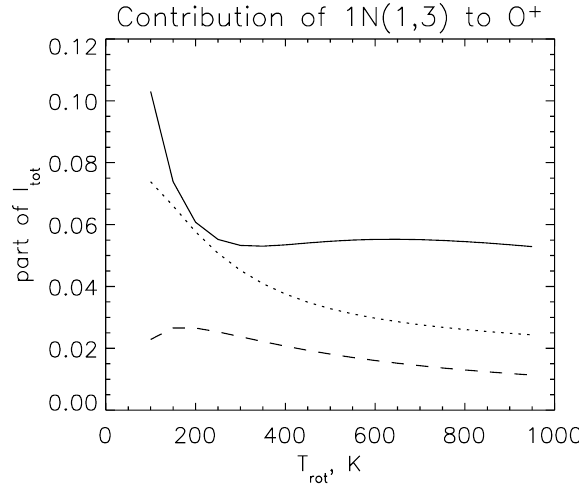
Fig. 5. Relative contribution of N + to the O1 (dashes), O2 (dots), and O3 (solid) spectral intervals, vs. the rotational temperature.